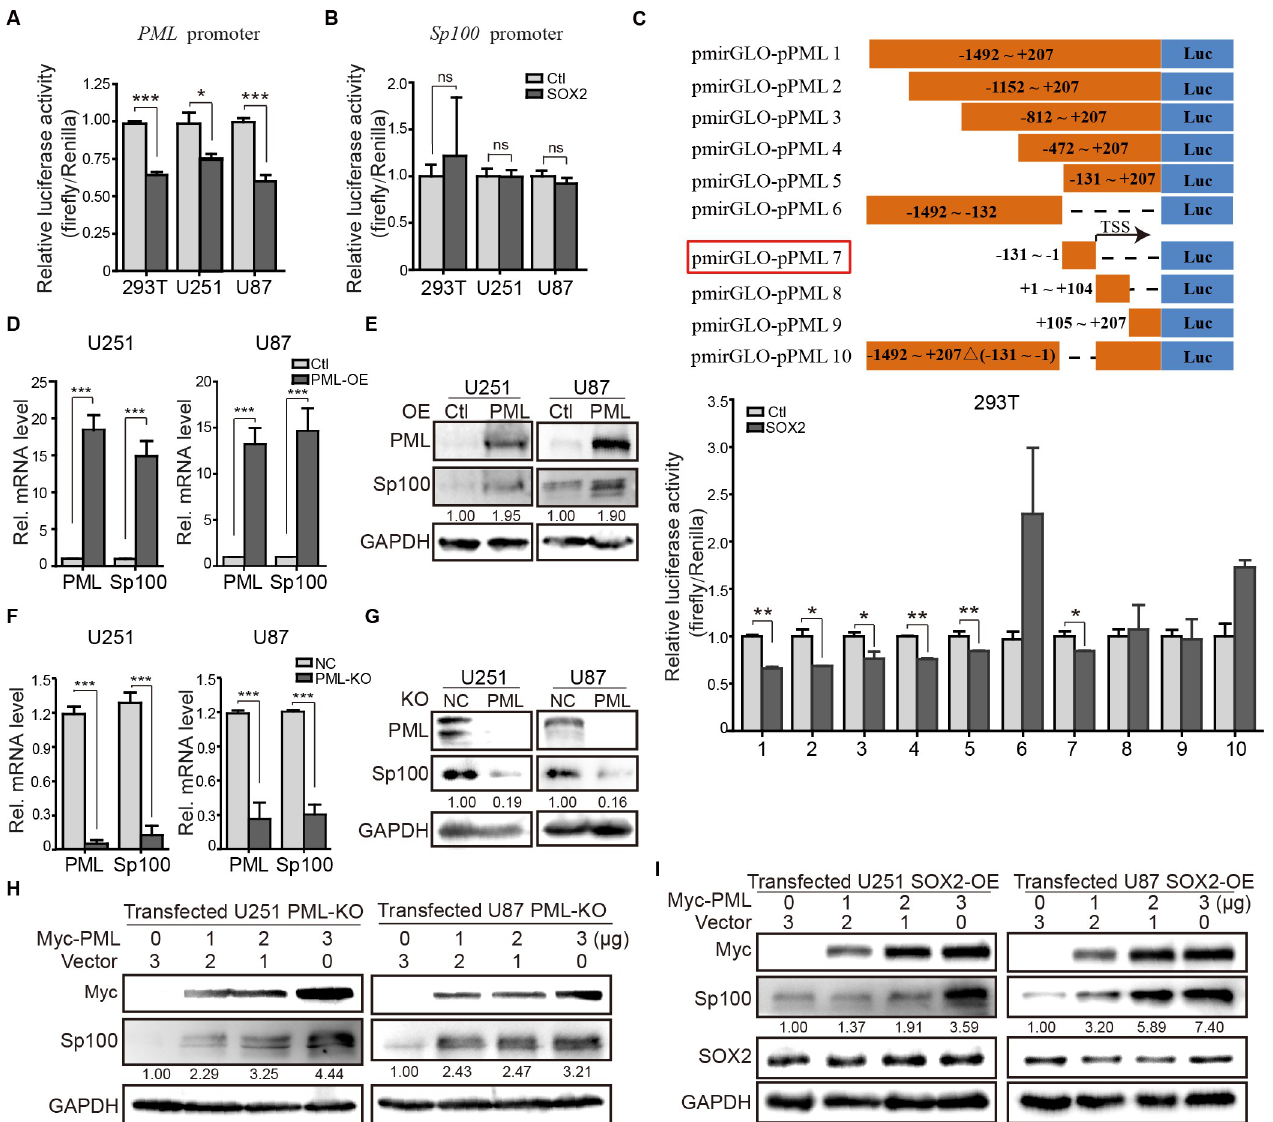
Fig 3. SOX2 downregulates PML and Sp100 by different mechanisms. Effects of SOX2 on the promoter activities of PML ( A ) and Sp100 ( B ) were assessed with a promoter-driven luciferase reporter system in 295T, U251, and U87 cells. ( C ) SOX2 suppresses PML expression by targeting the TSS region of the PML promoter. Luciferase expression driven by a series of truncated and deletion mutants of the PML promoter in 293T co-transfected with SOX2 or vector (Ctl) was quantified. Black lines indicate vector sequences, blue bars indicate luciferase reporter gene, and orange bars indicate the PML promoter fragments. Effects of PML overexpression on the mRNA ( D ) and protein ( E ) levels of PML and Sp100 in PML-OE and Ctl cells of U251 and U87. Effects of PML knockout on the mRNA ( F ) and protein ( G ) levels of PML and Sp100 in PML-KO and NC cells of U251 and U87. ( H ) Restored PML expression increases the Sp100 level. PML-KO U251 and U87 cells were transfected with the indicated amount of pHAGE-Myc-PML (Myc-PML) or vector (Ctl), and cells were collected 48h later for IB analysis of PML and Sp100. ( I ) PML expression restores endogenous Sp100 levels in SOX-OE cells. SOX2-OE U251 and U87 cells were transfected with the indicated amount of pHAGE-Myc-PML (Myc-PML) or pHAGE-GFP (vector), and cells were collected 48h later for IB analysis. Data in ( A , B, D and F ) are from three independent experiments and shown as mean ± SEM (Student’s t-test; ns, not significant; * , p < 0.05; ** , p < 0.01; *** , p <